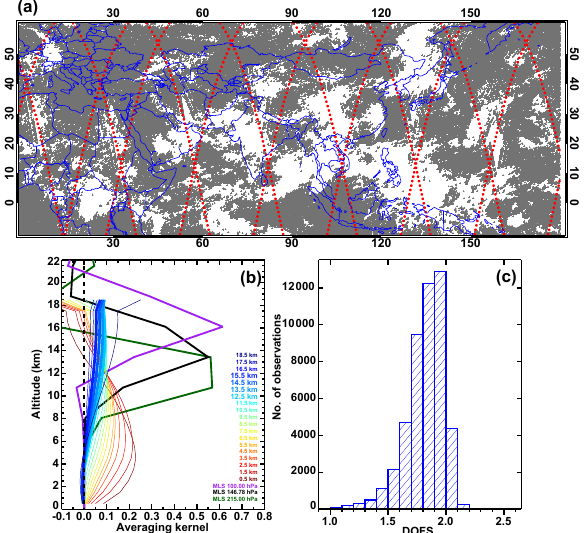
Figure 1. (a) Retrieval geolocations for IASI CO (gray crosses) and MLS CO (red dots) on 1 August 2008 for the study domain (0–180 ◦ E, 10 ◦ S–60 ◦ N). Both day and night observations are in- cluded. (b) IASI averaging kernels for 19 retrieval layers from the surface to 19km, labeled by the layer-center altitudes, and the stan- dard MLS averaging kernels for the UTLS products (215, 147, and 100hPa). The IASI curves are the averages of all profiles from the study domain on 1 August 2008. (c) Distribution of degrees of freedom for signal (DOFS) for all IASI profiles on 1 August 2008 within (0, 40 ◦ N) latitude and (40–150 ◦ E)